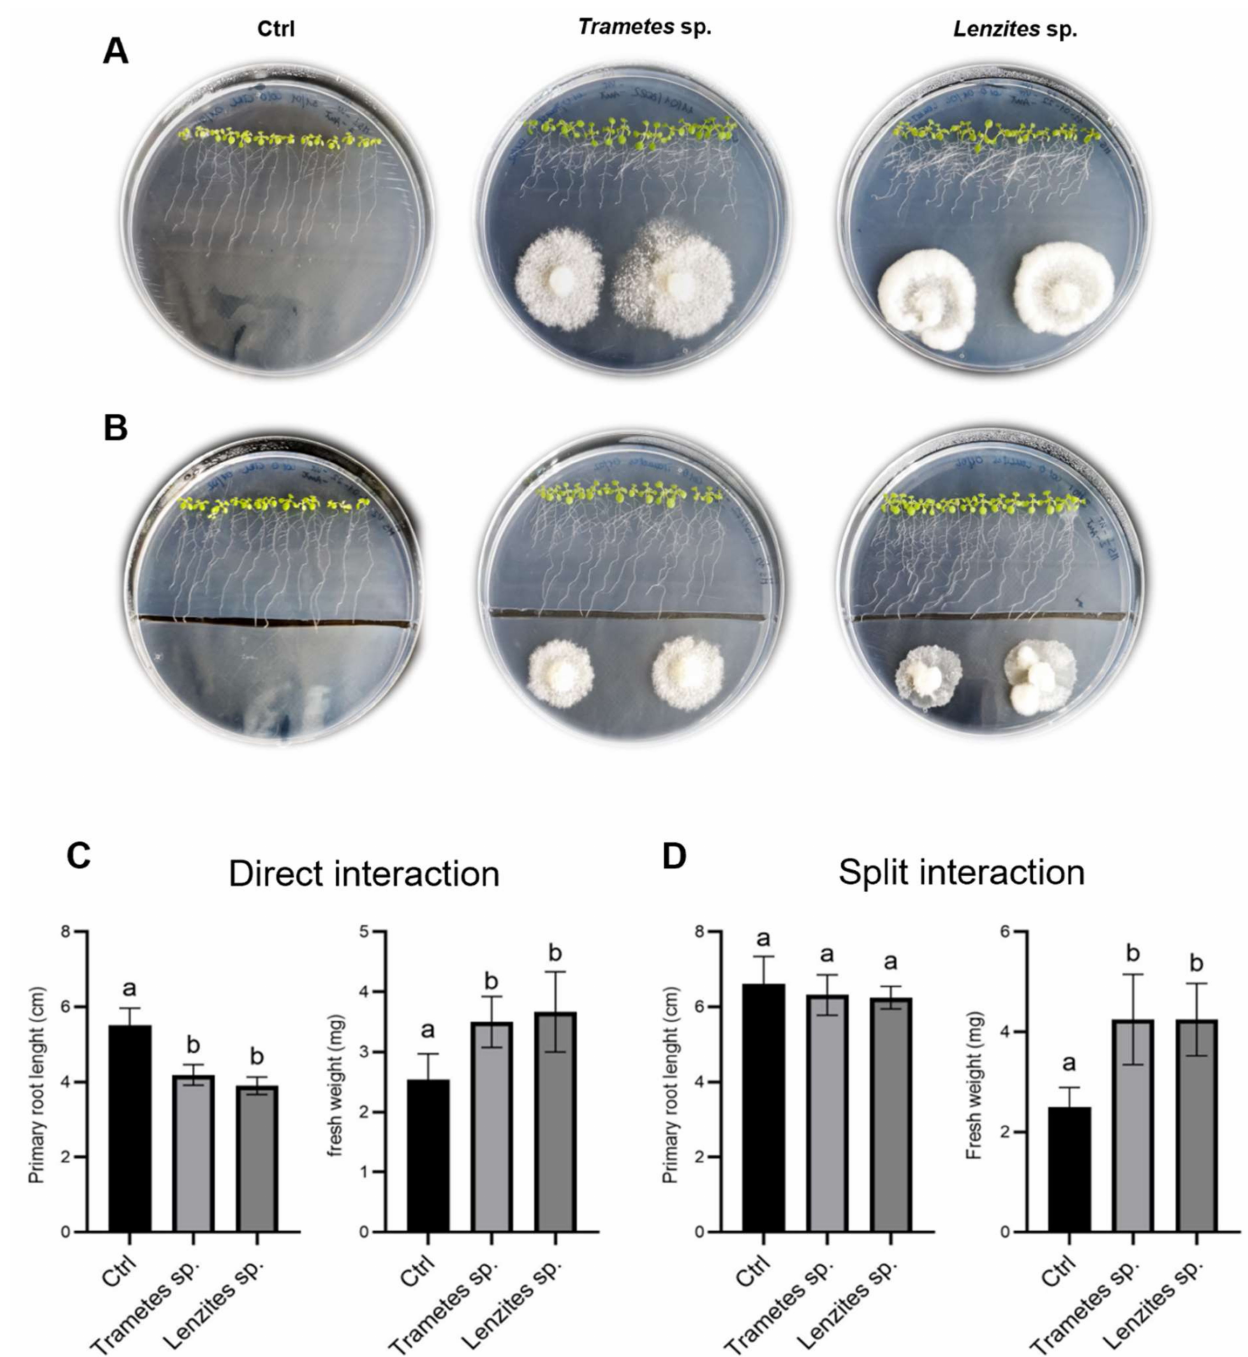
Figure 5. Effect of Trametes sp. S2.OA.C_F6 and Lenzites sp. S3.OA.B_F6 isolates on Arabidopsis growth. ( A , B ) Representative photos of 12-day-old Arabidopsis (Col-0) plantlets grown on MS 1 / 2 medium at 7 dpi. ( A ) Direct interaction experiments and ( B ) split interaction experiments. ( C , D ) Phys- iological parameter measurements. Primary root length (cm) and fresh weight (mg) measured in direct interaction experiments and ( C ) split interaction experiments ( D ). Bar plots represent mean ± SD ( n = 15). Different letters indicate significant differences (one-way ANOVA, p < 0.05; Tukey post hoc test, p <